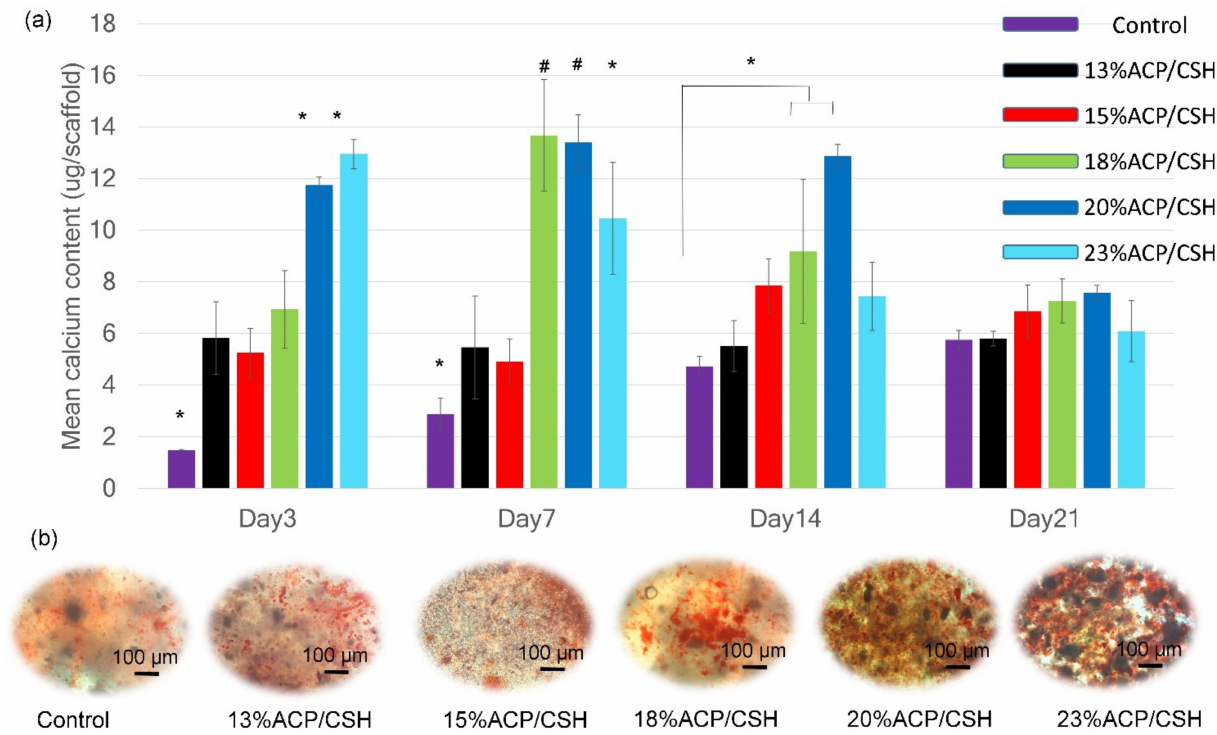
Figure 5. ( a ) Calcium deposition evaluated on days 3, 7, 14, and 21. ( b ) Calcium mineralization images represented by alizarin red stain on day 14 ( # p < 0.01, * p < 0.001). The light microscopy images revealed calcium mineralization identified by alizarin red dye. On day 14, the 18%ACP/CSH and 20%ACP/CSH groups provided much